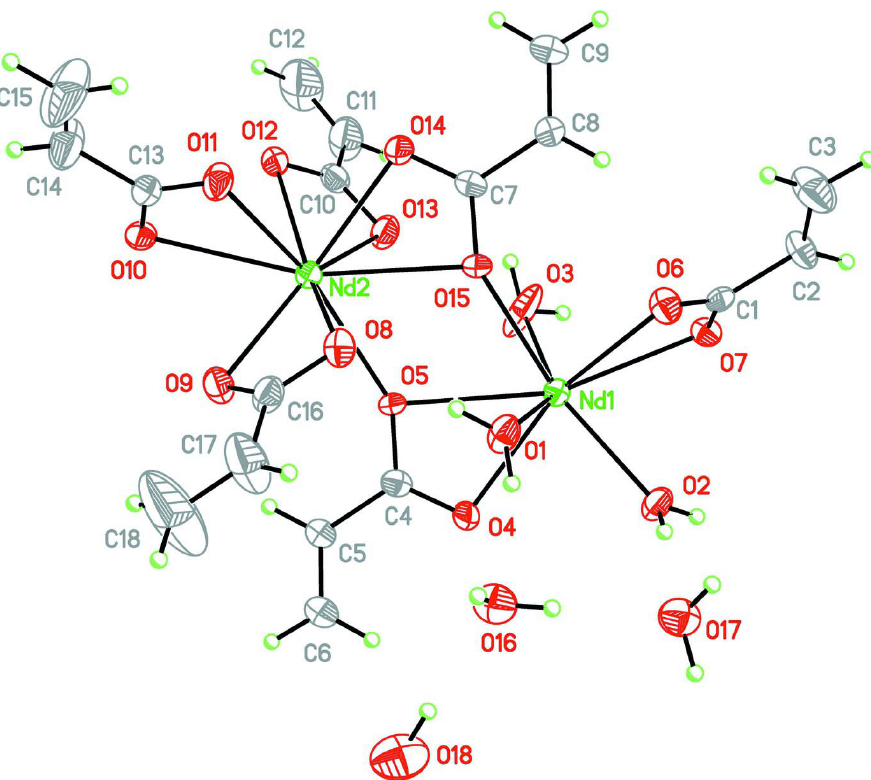
Figure 1 The asymmetric unit of the title compound with displacement ellipsoids drawn at 30% probability for non-H atoms.